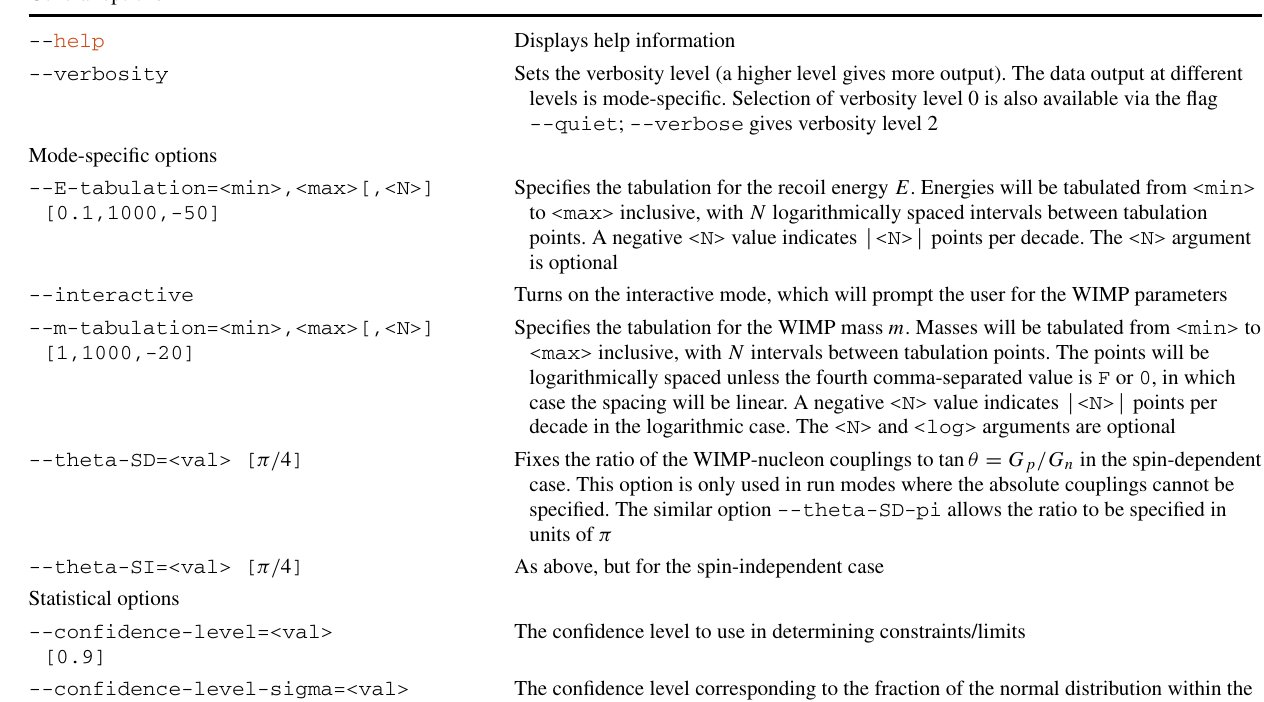
Table 4 Options of the DDCalc default executable DDCalc_run General